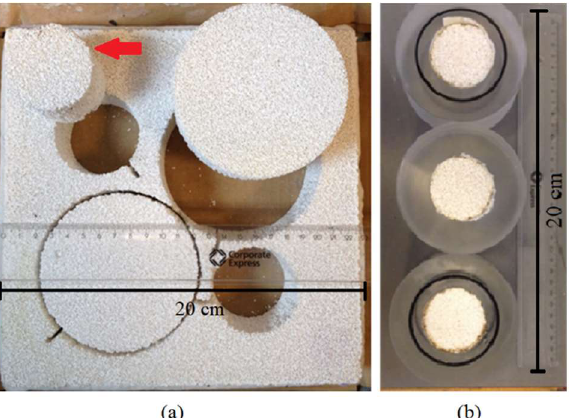
Figure 2. ( a ) a 9 inch 50 PPI filter with a sample taken from the filter and ( b ) the fully sealed samples